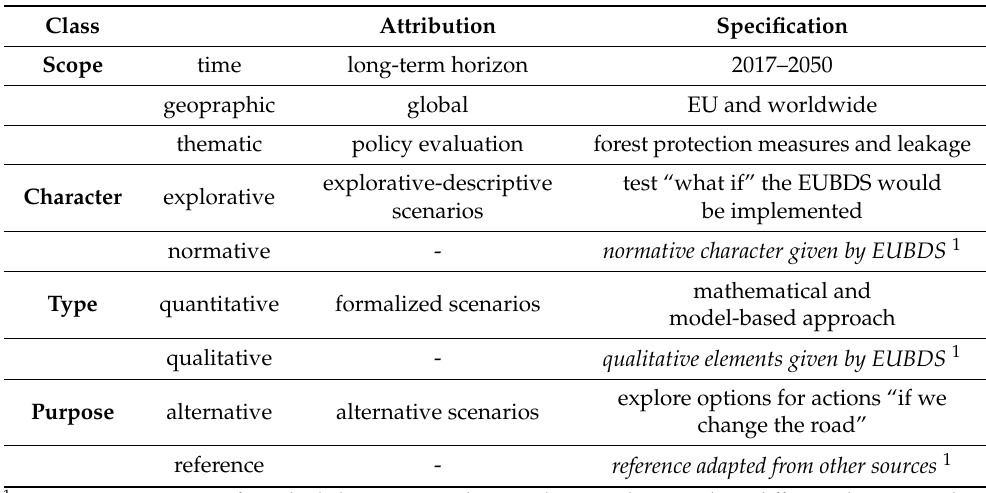
Table 1. Classification of scenarios developed for the purpose of the present study analysis (based on categorization of scenrios introduced in Kosow and Gaßner [23]).